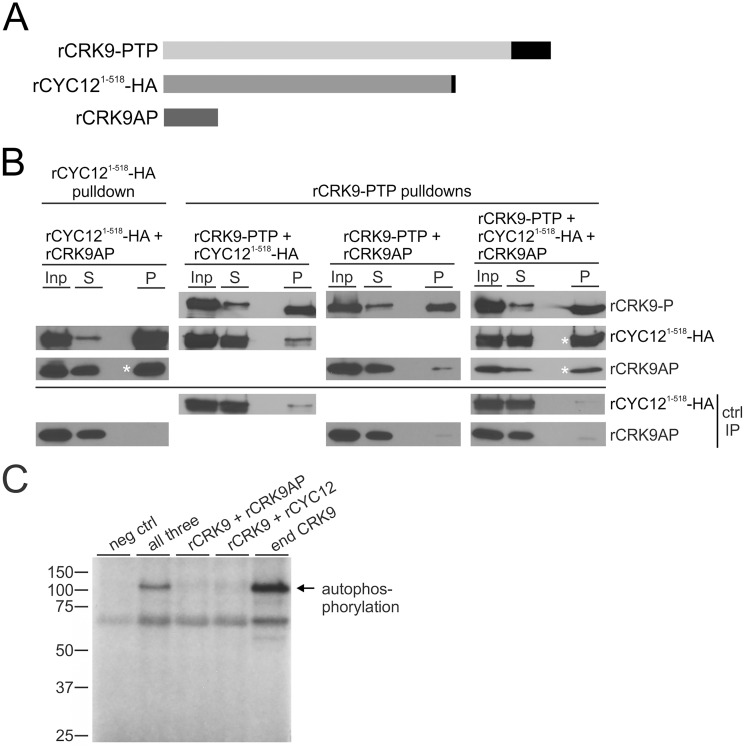
CRK9AP is essential for CRK9 enzyme assembly and autophosphorylation.(A) Schematic to scale of recombinant CRK9-PTP, CYC121-518-HA, and CRK9AP proteins that were expressed in wheat germ extract. PTP and HA tags are depicted as black boxes. (B) rCYC121-518-HA and rCRK9-PTP were pulled down from extract by anti-HA and IgG beads that bind to ProtA of the PTP tag, respectively. Pulldown and co-precipitation (asterisks) of CRK9 complex subunits were analyzed by immunoblotting with anti-ProtC (PTP tag), anti-HA and anti-CRK9AP antibodies, detecting the three proteins in extract (Inp), supernatant (S) and precipitate (P) which was loaded in six-fold excess to extract and supernatant. Negative control pulldowns (ctrl IP) were carried out with extract in which the target protein was not expressed. Note that IgG beads but not anti-HA beads reproducibly co-precipitated minor amounts of either rCYC121-518-HA and rCRK9AP in the control assays. (C) Kinase assay after IgG affinity chromatography and TEV protease release of rCRK9-P in the presence of all three complex components or with either CRK9AP or rCYC121-518-HA. In a negative control (neg ctrl), the assay was carried out without expression of trypanosome proteins and, in a positive control (end CRK9), CRK9 autophosphorylation was achieved by the endogenous CRK9 complex that was tandem affinity-purified from trypanosome extract. The labeled CRK9-P band is indicated on the right (autophosphorylation).